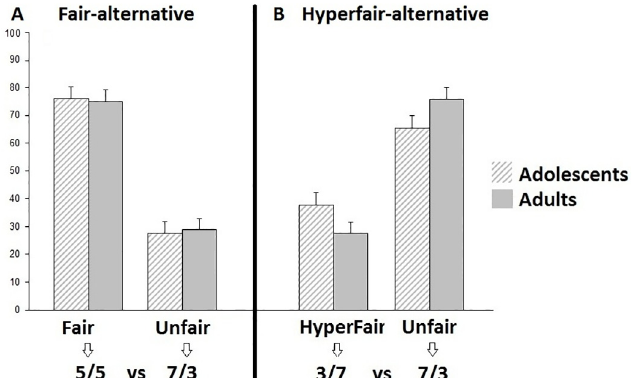
Fig 2. Behavioral results. In panel A the first column reflects the percentage of fair offers (5/5) and the second column reflects the percentage of unfair offers (7/3) made in the fair-alternative condition (5/5 vs 7/3). Both columns add up to 100%. In panel B the first column reflects the percentage of hyperfair offers (3/7) and the second column reflects the percentage of unfair offers (7/3) made in the hyperfair-alternative option (3/7 vs 7/3). Both columns add up to 100%. The error bars represent the standard